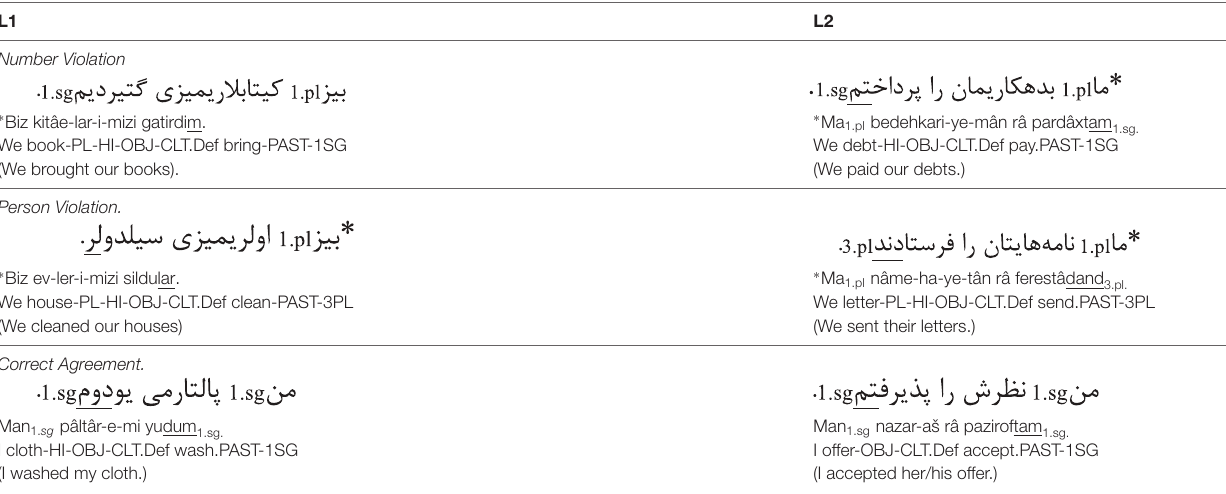
TABLE 1 | Examples for sentence materials. Example in Turkish and Persian with transliterations and literal translations in parenthesis* L1